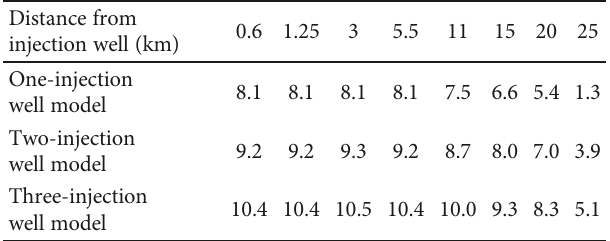
Figure 30: Pressure changes at the pressure monitoring points after cessation of CO injection in the 3-well model. 2 Table 3: The time it takes for the pressure at monitoring points at di ff erent distances from the injection well to return to the initial pressure (time: